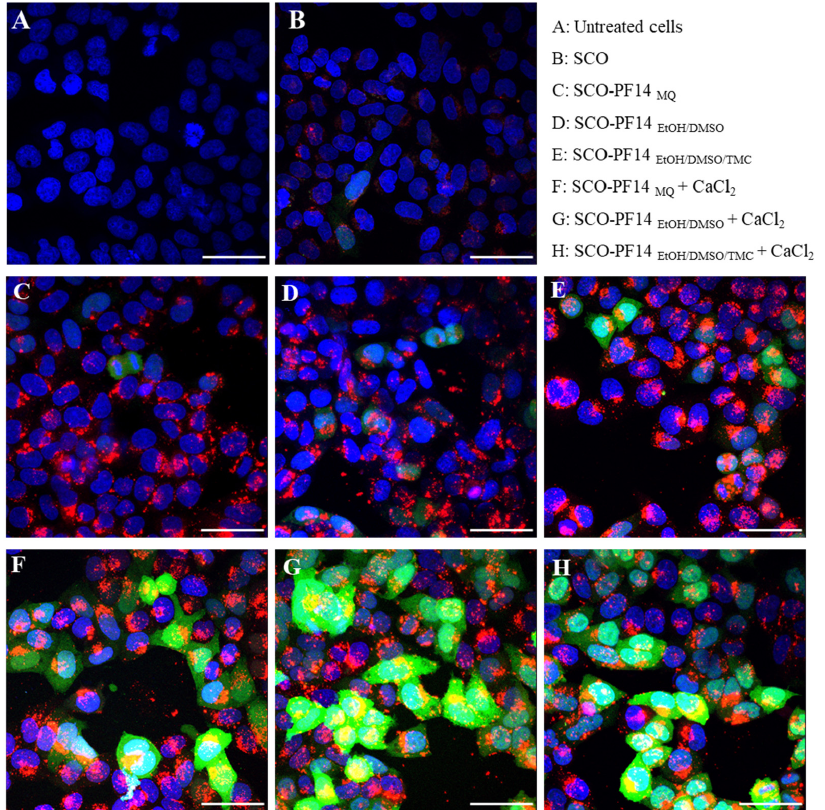
Figure 4. Internalisation and biological effect of nanoparticles containing SCO, differently dissolved PF14 and CaCl 2 . HeLa EGFP 654 reporter cells were incubated with nanoparticles of 180 nM SCO-654, 20 nM Cy5-SCO-654, 1 µM PF14 and 3 mM CaCl 2 for 24 h. Cells were fixed, and specimens were analysed with Olympus FluoView FV1000 confocal microscope. Cells were either left untreated ( A ), incubated with the two SCOs ( B ), the SCO-PF14 nanoparticles ( C – E ) or the SCO-PF14-Ca 2+ nanoparticles ( F – H ). The following PF14 stocks were used: PF14 dissolved in MQ water ( C , F ); PF14 dissolved in EtOH90/DMSO10 mixture ( D , G ); and PF14 dissolved in EtOH90/DMSO9.6/TMC0.4 mixture ( E , H ). Rescued EGFP expression is shown in green. Cell nuclei were visualised with DAPI (blue). For tracking cellular association and internalisation of oligonucleotide, Cy5-labelled SCO was used (red). The merged images of all confocal layers are presented. Scale bar: 50 µm.